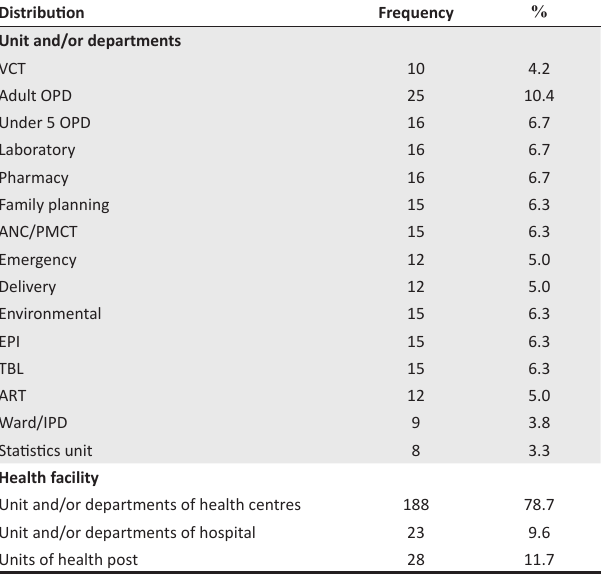
TABLE 1: Distribution of units and/or departments heads of hospital, health centres and health posts in Dire Dawa Administration health facility, April 2013. Distribution